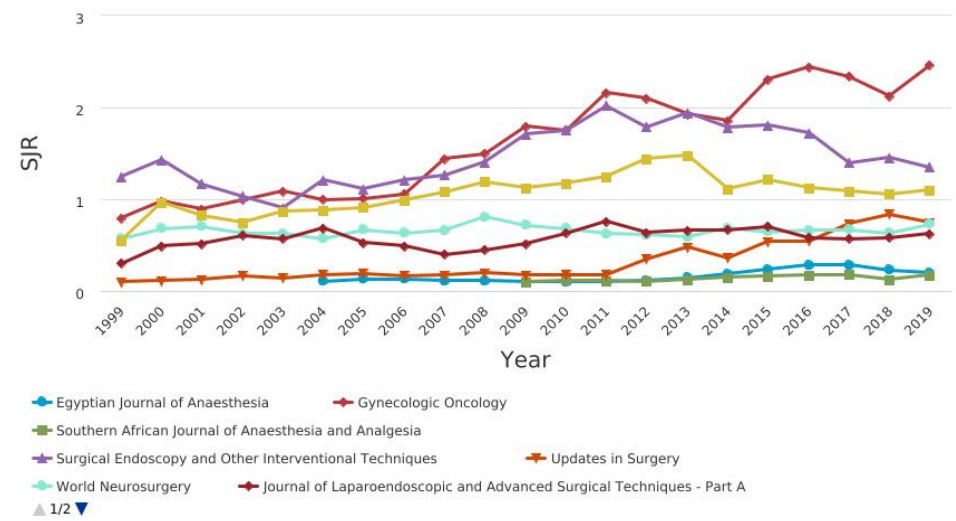
Figure 7. SCImago journal rank (SjR) of pain, anesthesia, and surgery journals.